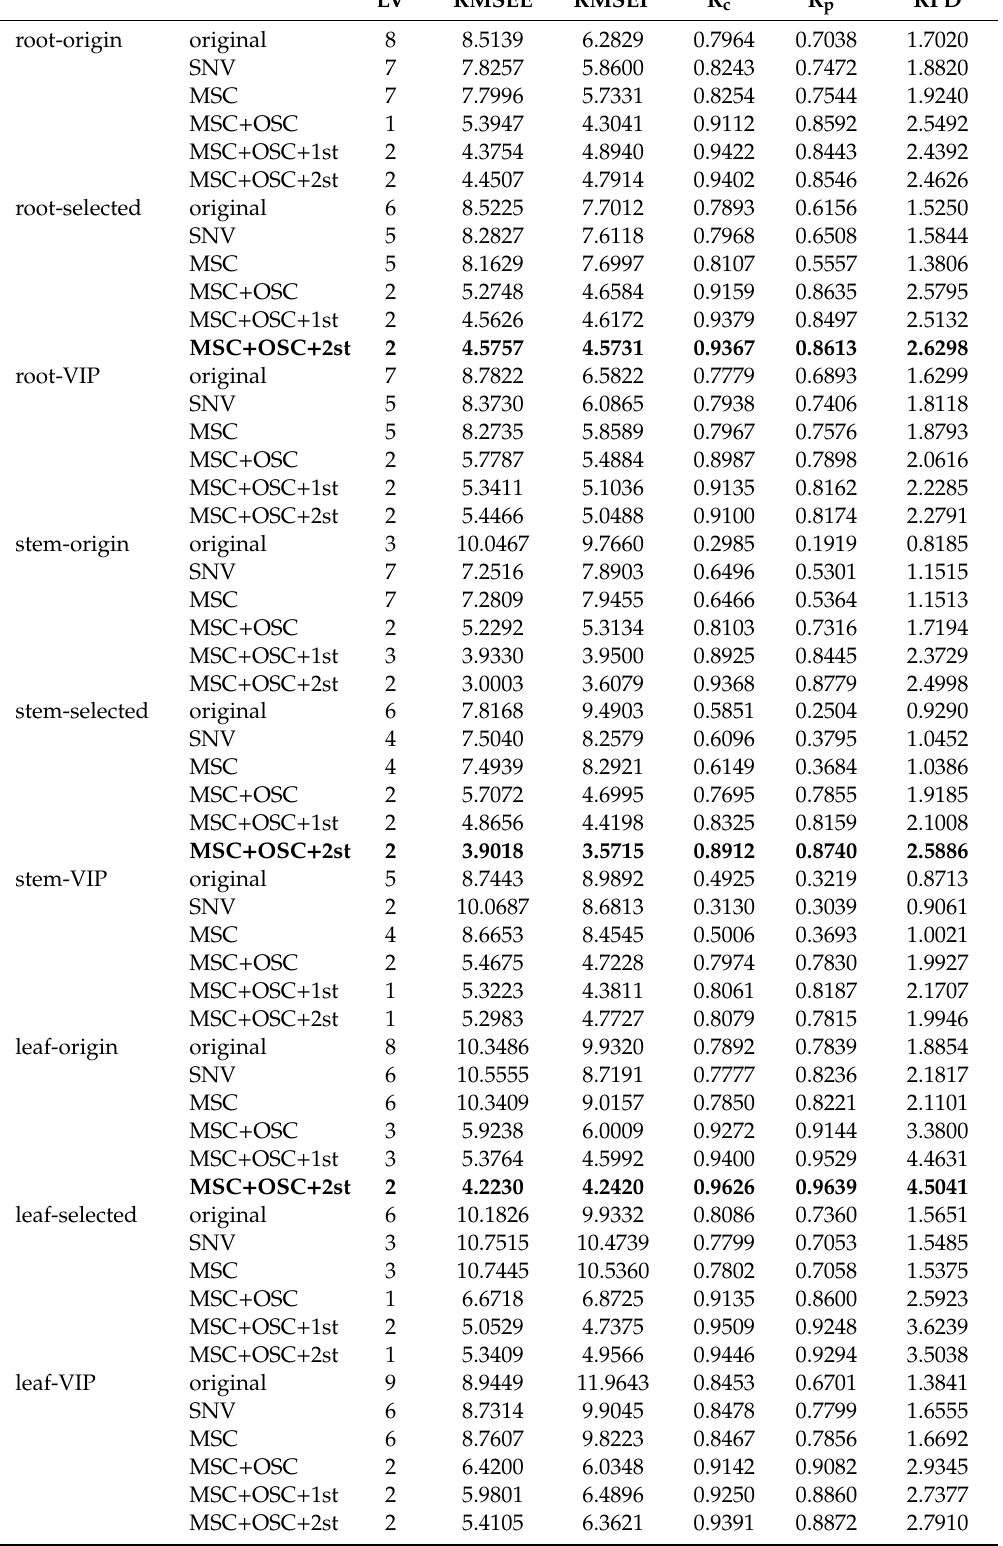
Table 4. Various variable selected and pretreatments combined with PLSR for total